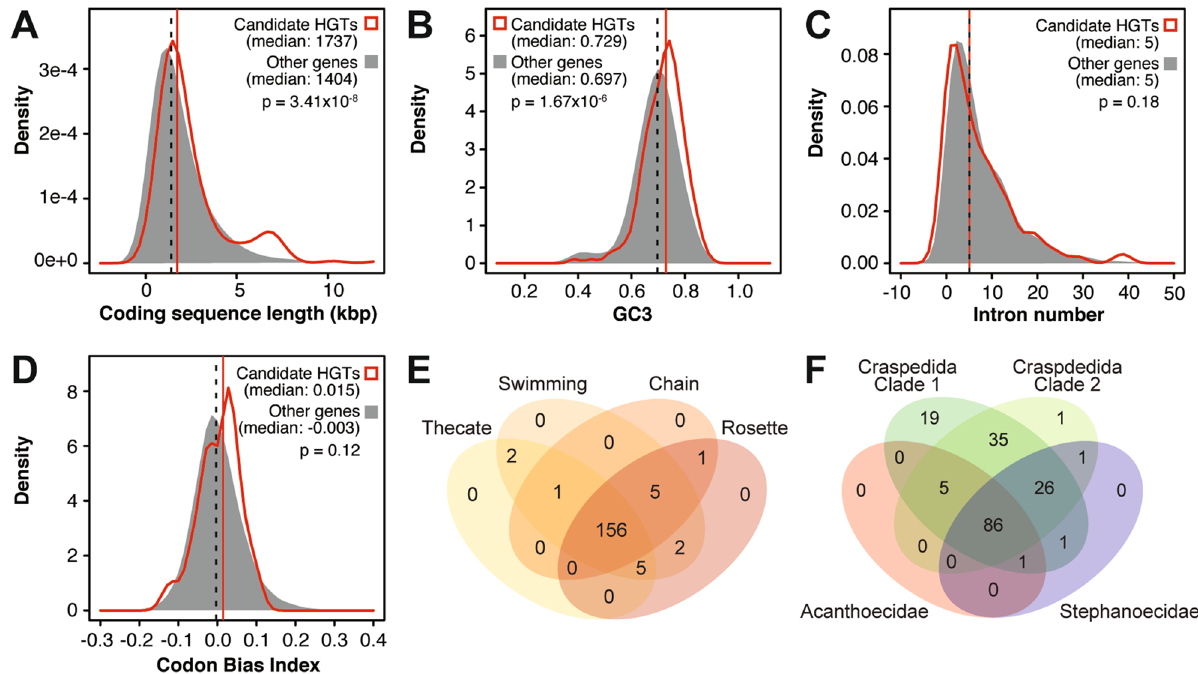
Figure 2. Gene architecture of candidate HGTs. Density plots showing the distribution of ( A ) coding sequence length, ( B ) GC content at the third codon position (GC3), ( C ) intron number, and ( D ) codon bias index in candidate horizontally transferred genes (red) in comparison to the bulk of S. rosetta genes (gray). ( E ) Number of HGT candidates that are expressed in the indicated life stages of S. rosetta . ( F ) Number of HGT candidates conserved in other choanoflagellate